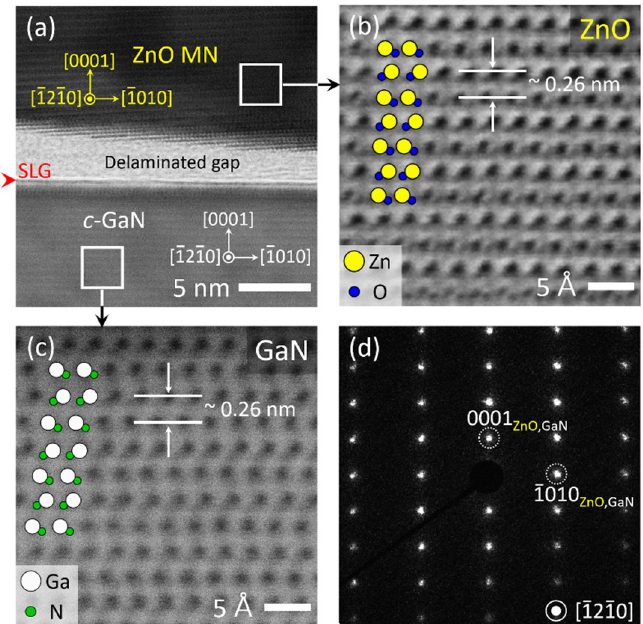
Figure 5. Cross-sectional AR-STEM and SAED analyses of remote epitaxial ZnO MN grown on SLG/GaN. ( a ) Low magnification image of c -ZnO MN/SLG/ c -GaN. AR-STEM image of ( b ) ZnO MN and ( c ) c -GaN substrate in a bright-field mode, taken from boxed areas marked in ( a ). ( d ) SAED patterns of the remote epitaxial c-ZnO